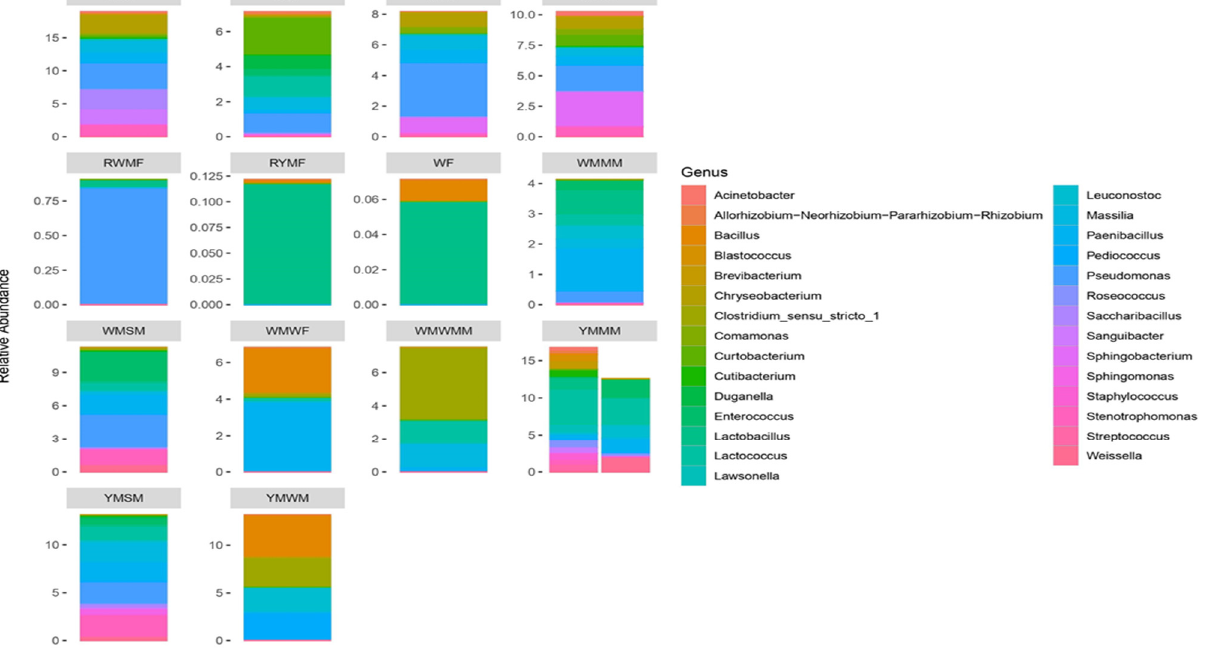
Figure 1. Bacterial taxa at the genus level for optimised mahewu samples. MMF—malted millet flour, MSF—malted sorghum flour, MWF—Malted white maize flour, MYMF—malted yellow maize flour, RWMF—raw white maize flour, RYMF—raw yellow maize flour, WF—wheat flour, WMMM -white maize mahewu with malted millet, WMSM—white maize mahewu with sorghum malt, WMWF—white maize mahewu with wheat flour, WMWMM—white maize mahewu with white maize malt, YMMM—yellow maize mahewu with malted millet, YMSM—yellow maize mahewu with sorghum malt, YMW—yellow maize mahewu with wheat.